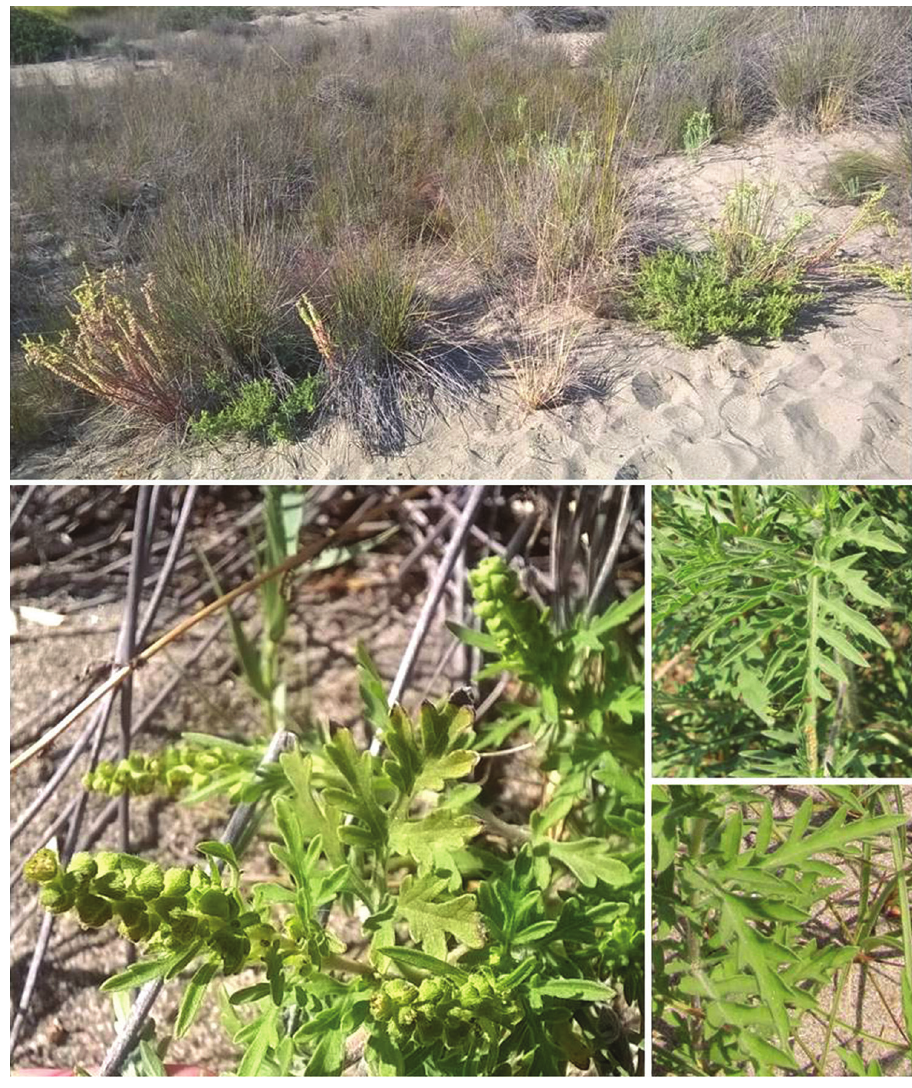
Figure 7. Ambrosia maritima in Sardinia: plants in their coastal dunes habitat, comparison between leaves of A. maritima and exotic ragweeds A. artemisiifolia ( a ) and A. psilostachya ( b ). Photographs by C.